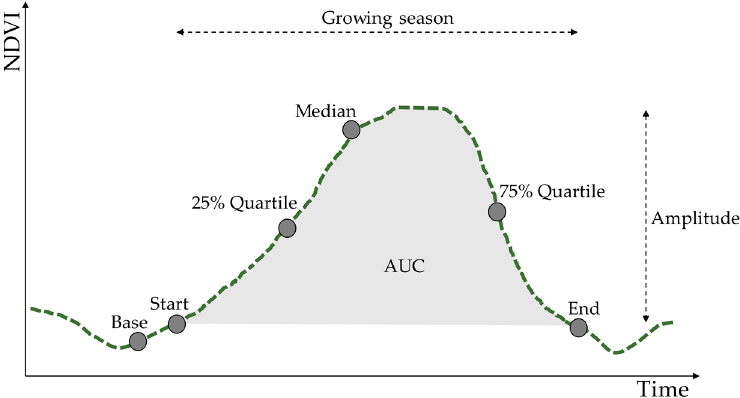
Figure 2. The normalized difference vegetation index (NDVI) phenological metrics for the entire growing season. The phenological metrics are statistical descriptors of the NDVI trajectory of a pixel.